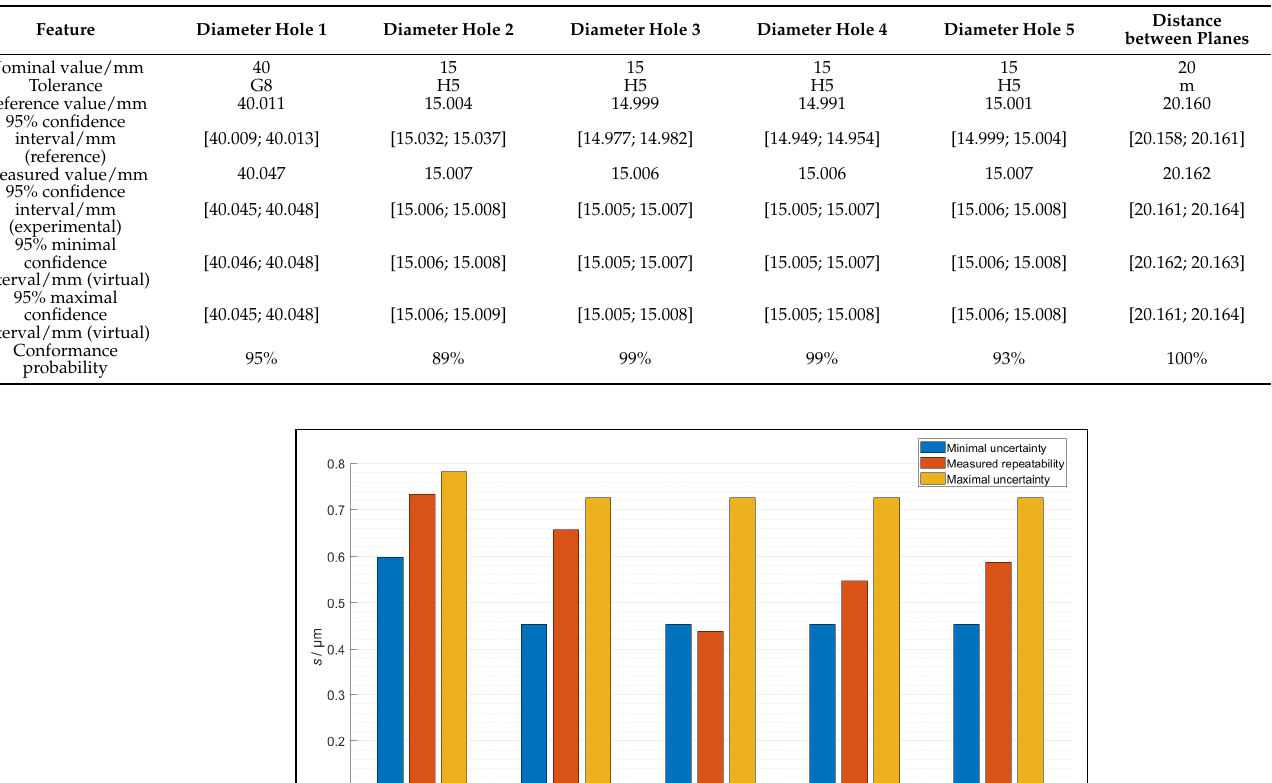
Table 1. The specifications, measurements and simulations for all critical features.